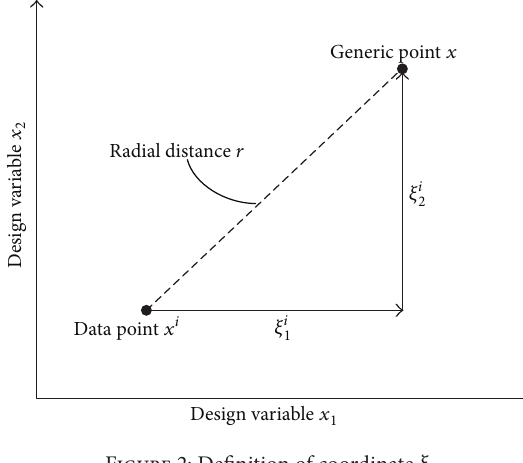
Figure 2: Definition of coordinate 𝜉 .